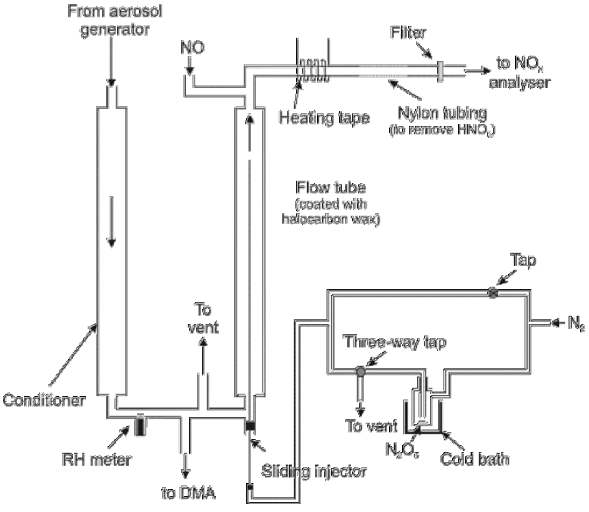
Fig. 5. Schematic of aerosol flow tube for measurements of uptake coefficients (from Badger et al., 2006). In this case N 2 O 5 was measured using a chemiluminescence method after titration with NO added at the reactor exit.